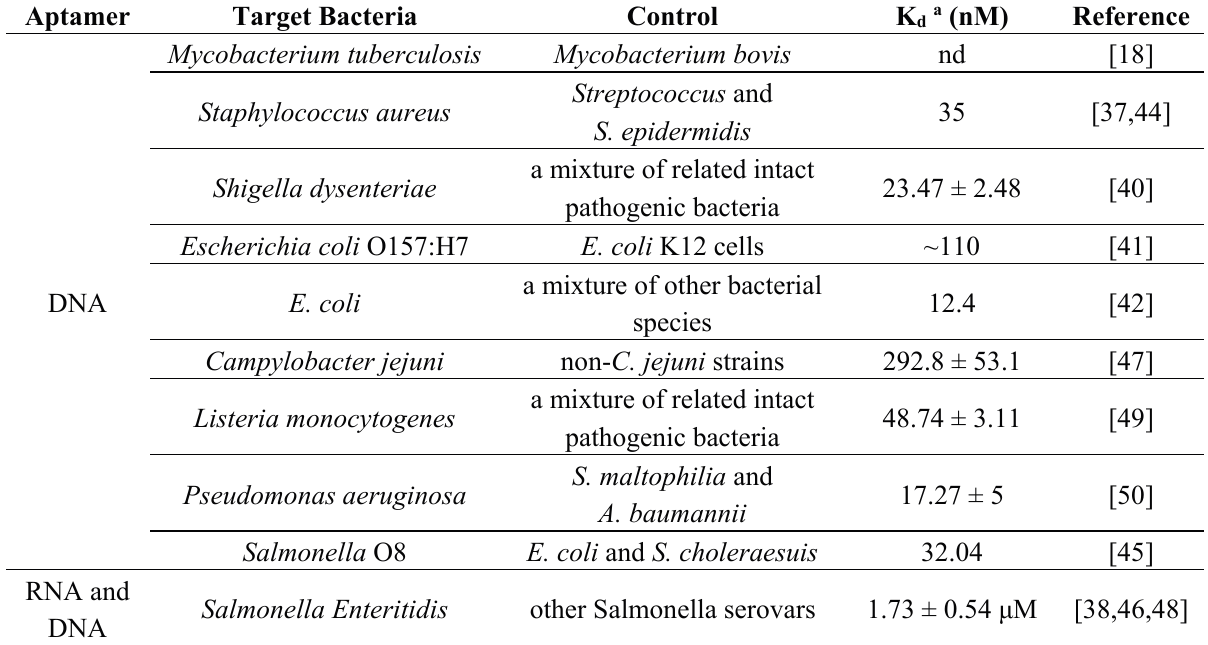
Table 2. Summary of aptamers selected against bacteria using bacterium-SELEX. Aptamer